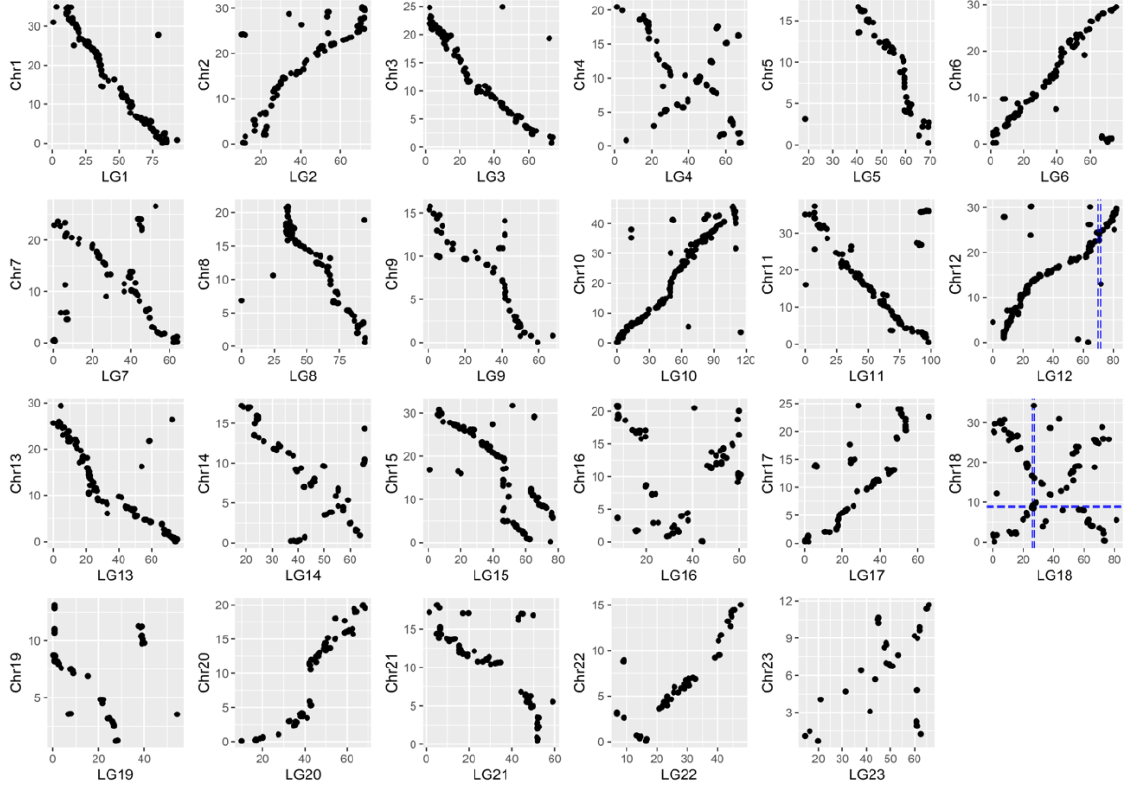
Figure 2. Visualization of chromosome-scale synteny by comparing the location of markers along the P. angustifolia linkage groups (LG, scale in cM) with the location of their best BLAST hit along the homologous olive tree chromosome (Chr, scale in Mbp). The vertical lines on LG12 and LG18 indicate the position of markers strictly associated with sex and SI phenotypes in P. angustifolia , respectively. The horizontal line on Chr18 indicates the chromosomal region containing the SI locus in Olea europaea according to Mariotti et al .